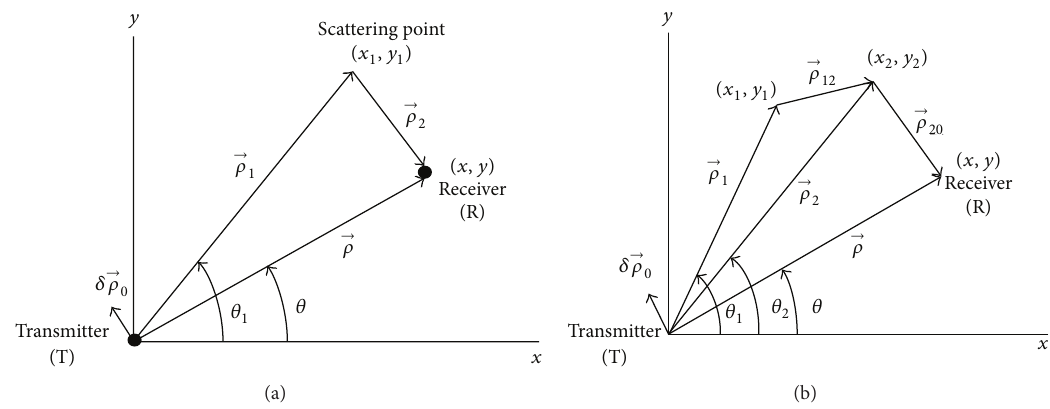
Figure 1: General (a) first-order and (b) second-order bistatic scatter geometry with antenna